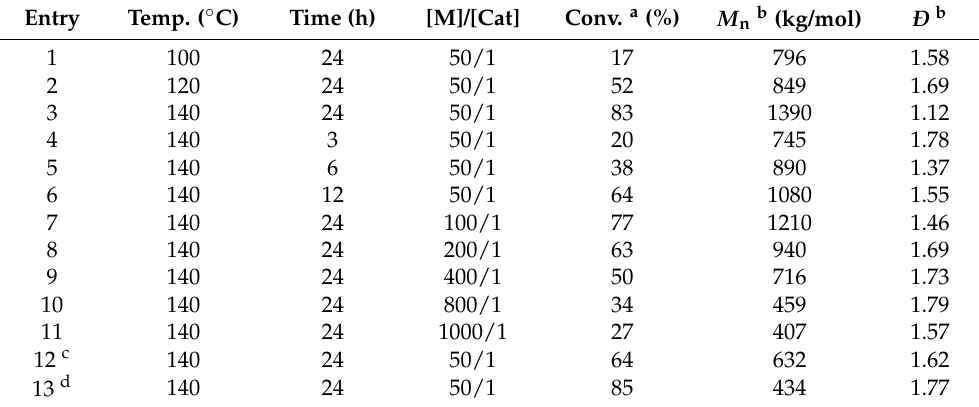
Table 1. Experimental results of MMA polymerization using ZIF-L at various temperatures and MMA/ZIF-L